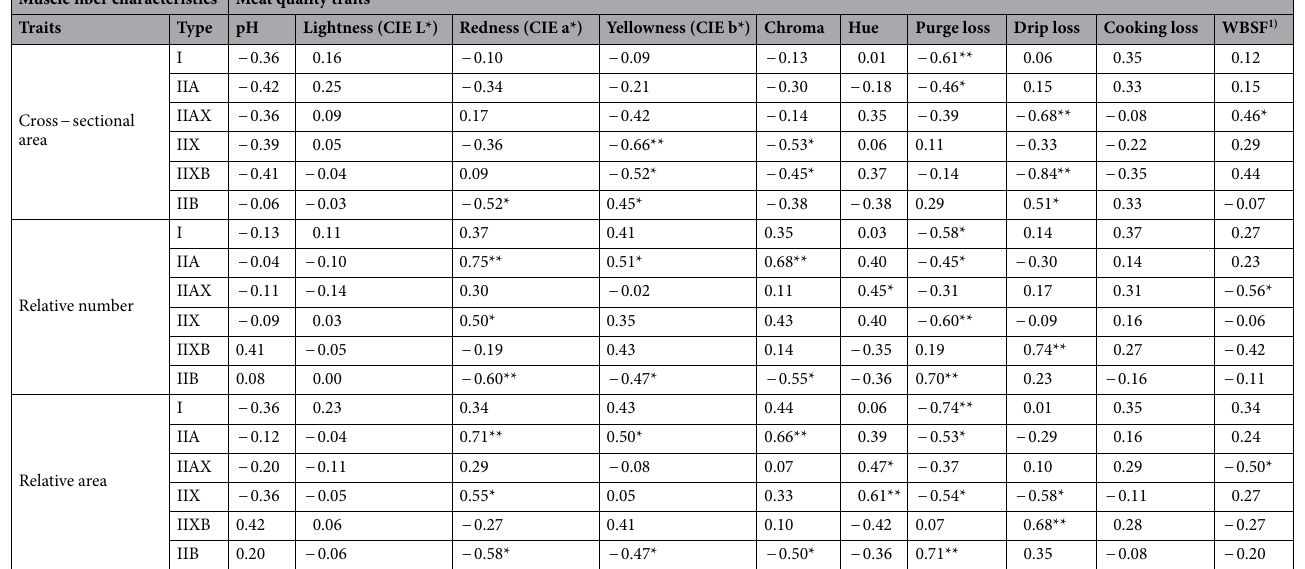
Table 3. Correlation coefficients between muscle fiber characteristics and the difference in meat quality between fresh and frozen-thawed pork. 1) Warner–Bratzler shear force. * P < 0.05; ** P <